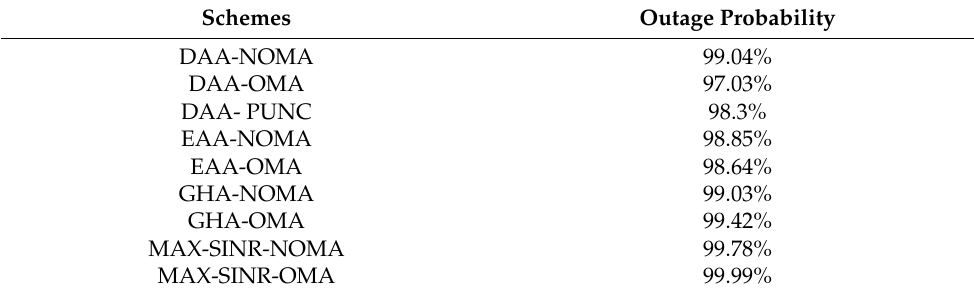
Figure 7. The outage-probability for uRLLC UEs versus number of uRLLC UEs. Table 4. Outage Probability for uRLLC